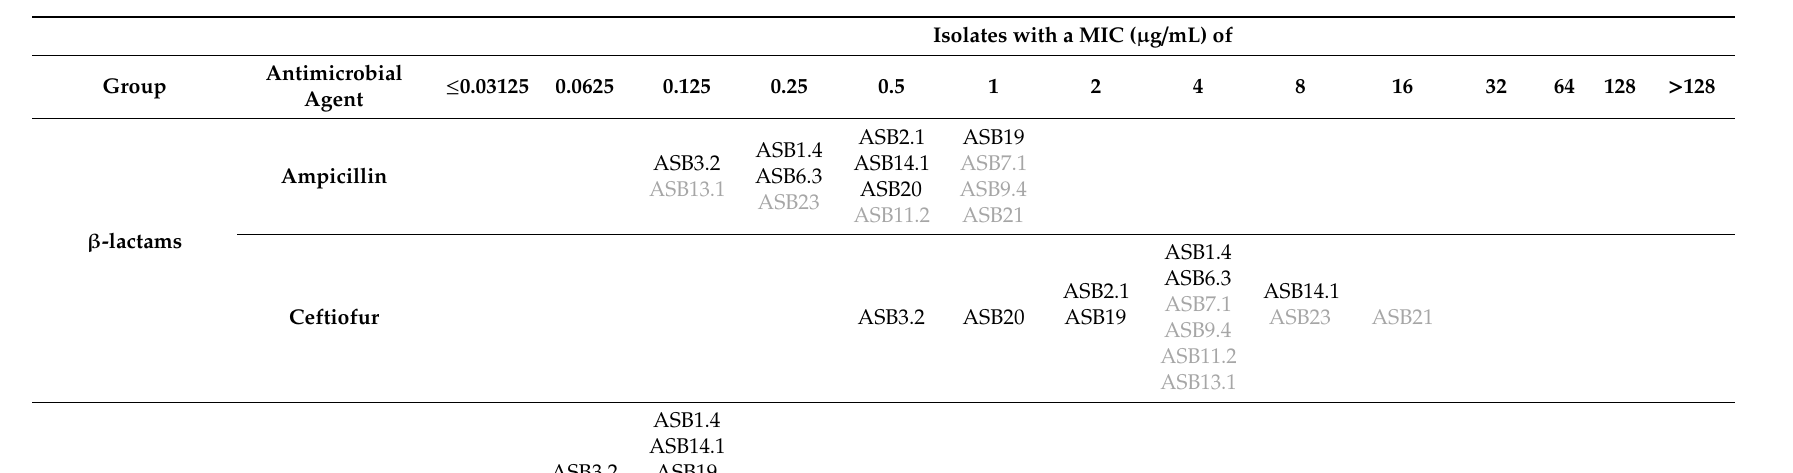
Table 1. Detailed overview of MIC distribution of seven H. heilmannii and six H. ailurogastricus isolates. Feline H. heilmannii isolates: ASB1.4, ASB2.1, ASB3.2, ASB6.3, ASB14.1, ASB19, and ASB20. Feline H. ailurogastricus isolates: ASB7.1, ASB9.4, ASB11.2, ASB13.1, ASB21, and ASB23. H. heilmannii isolates showing acquired antimicrobial resistance are indicated in bold and